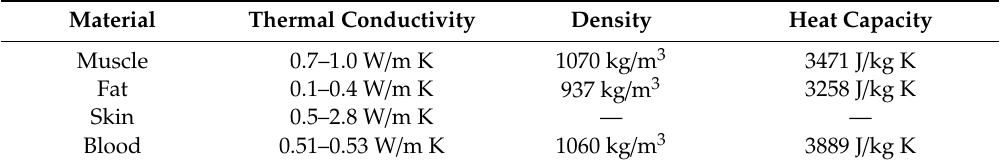
Table 2. Material properties and convective heat transfer coe ffi cients used for tissue thermal